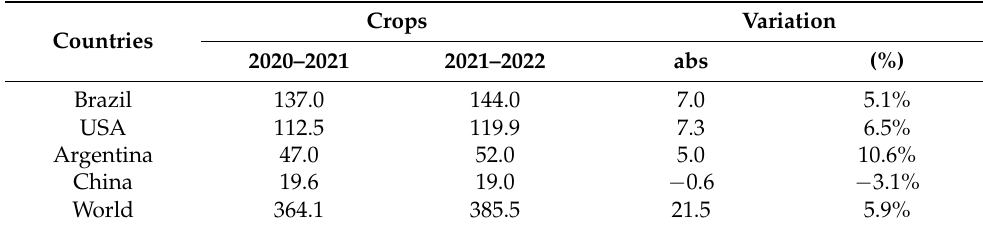
Table 5. World soybean production (million t). Source: [2]. Countries